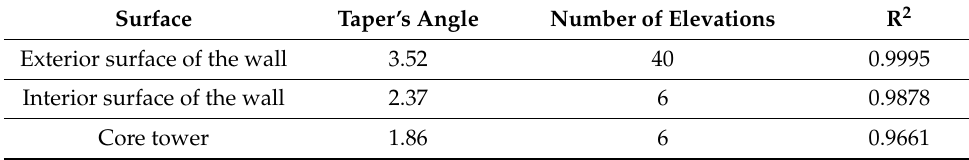
Table 2. Results of linear regression analysis for taper estimates.